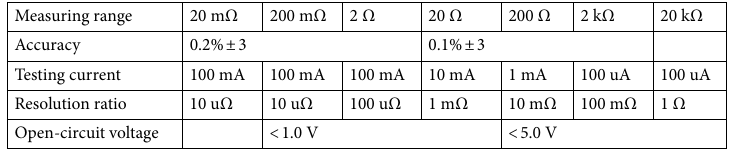
Table 1. Specific indicators of the intelligent resistivity